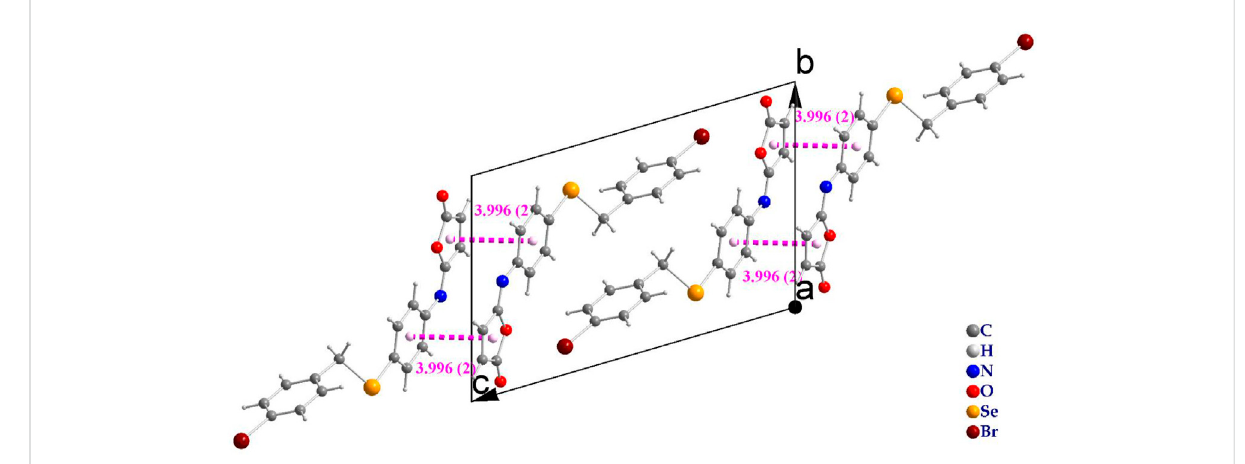
FIGURE 3 Slipped π -stacked dimers of isomaleimide 4